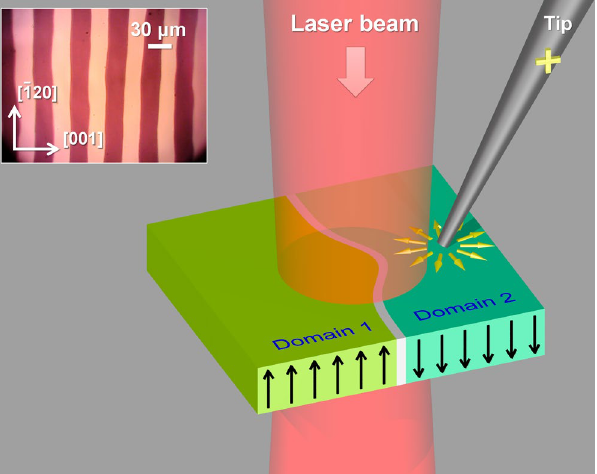
Figure 1. General layout of the experiment and stripe domains structure of the sample. Yellow arrows show schematically the electric field of the tip; black arrows – magnetizations of the adjacent domains; bright region between the domains is domain wall. The flexomagnetoelectric effect causes domain wall shift resulting in bulge shape of the wall. (Inset) Magneto-optical image of the stripe domain structure of the sample – 7.4- μ m-thick epitaxial iron garnet film of composition (BiLu) 3 (FeGa) 5 O 12 – obtained with the polarization microscope. Angle between the polarizer and analyzer is 20°; external magnetic field of 8 mT is in-plain and perpendicular to the